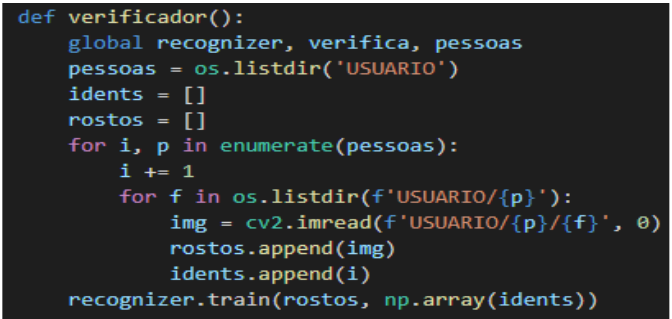
Figure 14: Face recognition function from the image bank.